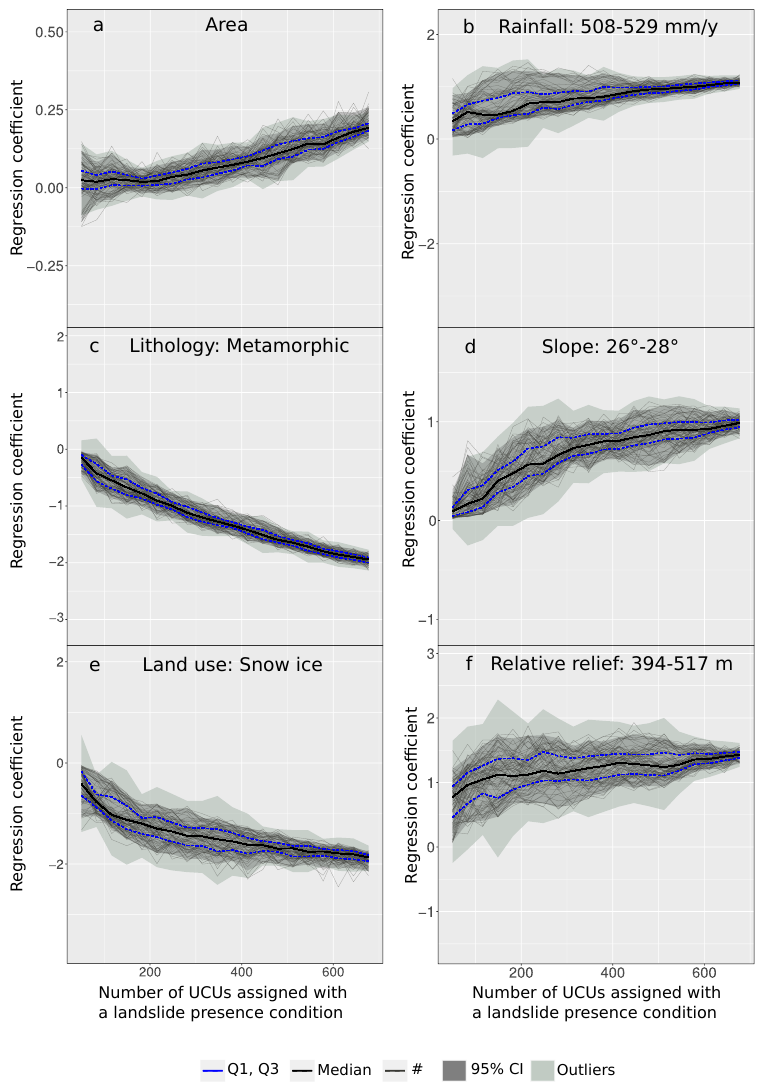
Figure 10. Example of covariate effects estimated at a varying proportion of landslide presence data for: ( a ) Area, ( b ) annual rainfall, ( c ) lithology, ( d ) slope, ( e ) land use, and ( f ) relative